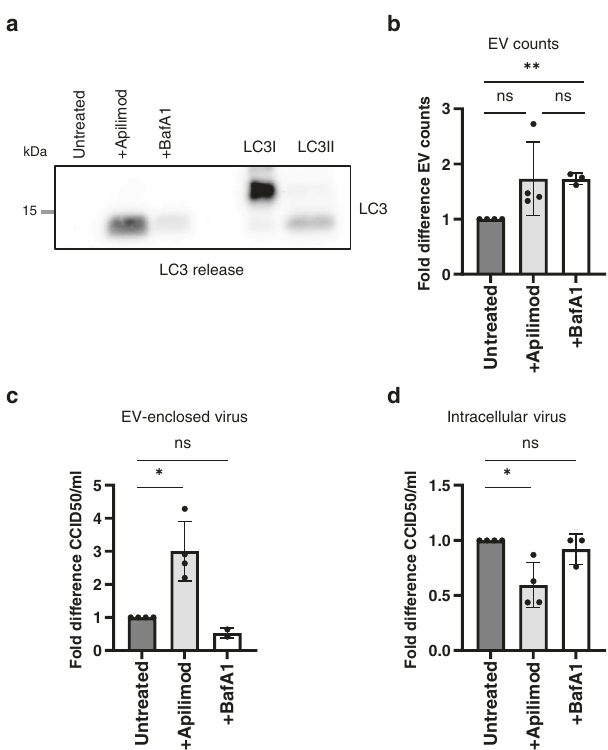
Fig. 6 Apilimod reactivates secretory autophagy and promotes EV- enclosed virus release in the absence of the EMCV Leader. a EMCV-L Zn infected cells were treated with 500 nM apilimod for 16 h prior to infection or 200 nM BafA1 1 h p.i. onwards. EV-containing 100,000× g ultracentrifugation pellets were isolated from supernatants of an equal number of cells at 8 h p.i. and analyzed by western blot for the presence of extracellular released LC3. Depicted is a representative image of n = 2 independent experiments. LC3I PC and LC3II PC are positive control samples for western blot detection of LC3I and LC3II, respectively. b 100 K EVs were labeled with CFSE, puri fi ed by density gradient centrifugation, and analyzed by high-resolution fl ow cytometry. Bars indicate the mean fold increase in EV release relative to untreated controls ±SD from n = 3 (BafA1) or n = 4 (apilimod) independent experiments. ** p = 0.0064, ns (left) p = 0.1148 as assessed by a two-tailed one-sample t -test, or two-tailed t - test for ns (right) p = 0.9936. c , d Depicted is the mean fold increase in EV- enclosed infectivity ( c ) and intracellular virus titers ( d ) relative to untreated controls ±SD corresponding to the samples in ( b ) as determined by end- point dilution assay. For c * p = 0.0210, ns p = 0.1464, for d * p = 0.0285, ns p = 0.4226, as assessed by a two-tailed one-sample t -test. Source data are provided as a Source Data fi partial disassembly of autophagic membranes in amphisomes, which may liberate LC3 from its membrane con fi nement and result in the release of LC3 that is exposed to the environment.